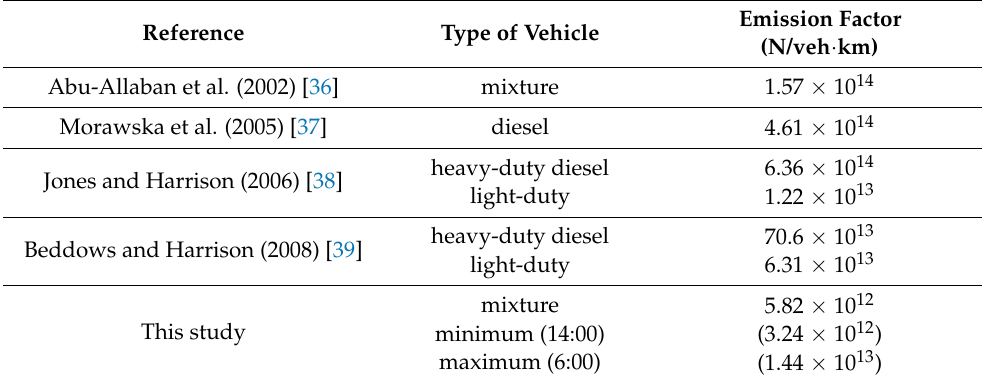
Table 1. Vehicle emission rate of particle number